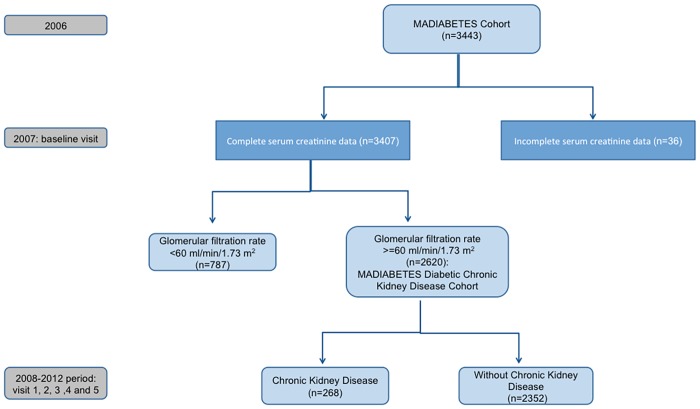
Flow diagram of participants.